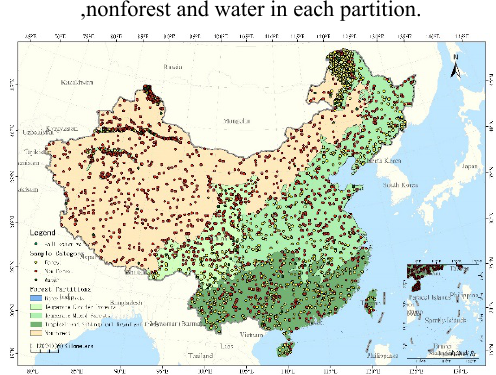
Figure 3. The samples map of